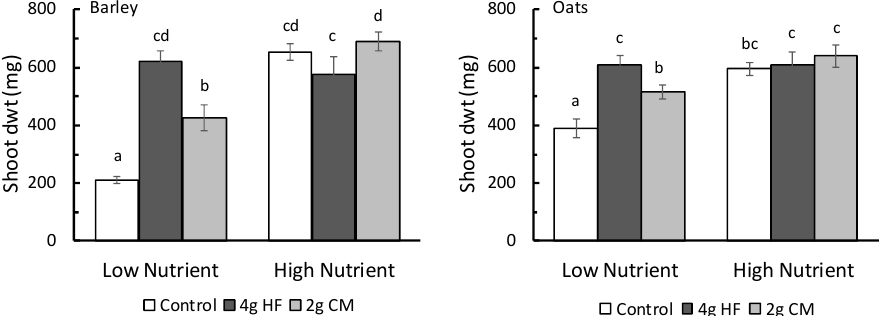
Figure 1. The response of barley and oat shoot dry weight (dwt; mg; mean ± se; N = 10) grown under greenhouse conditions to the application of HexaFrass (HF; 4 g/pot) and chicken manure organic fertilizer (CM; 2 g/pot) with low nutrient and high nutrient potting media. Treatments not sharing the same letter code are separated by Fisher’s LSD ( p < 0.05).